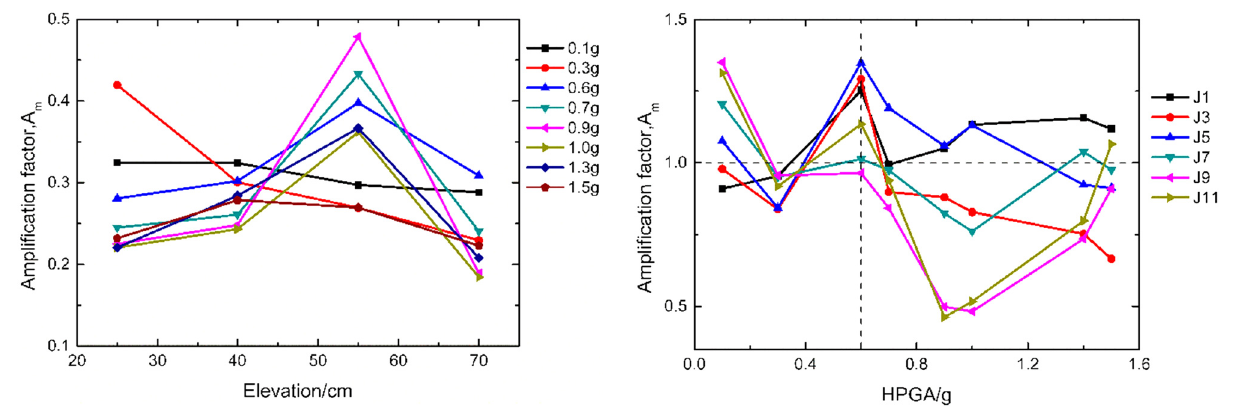
Figure 16: Ampli fi cation factor A m at J1, J3, J5, J7, J9, and J11 vs variable HPGA.